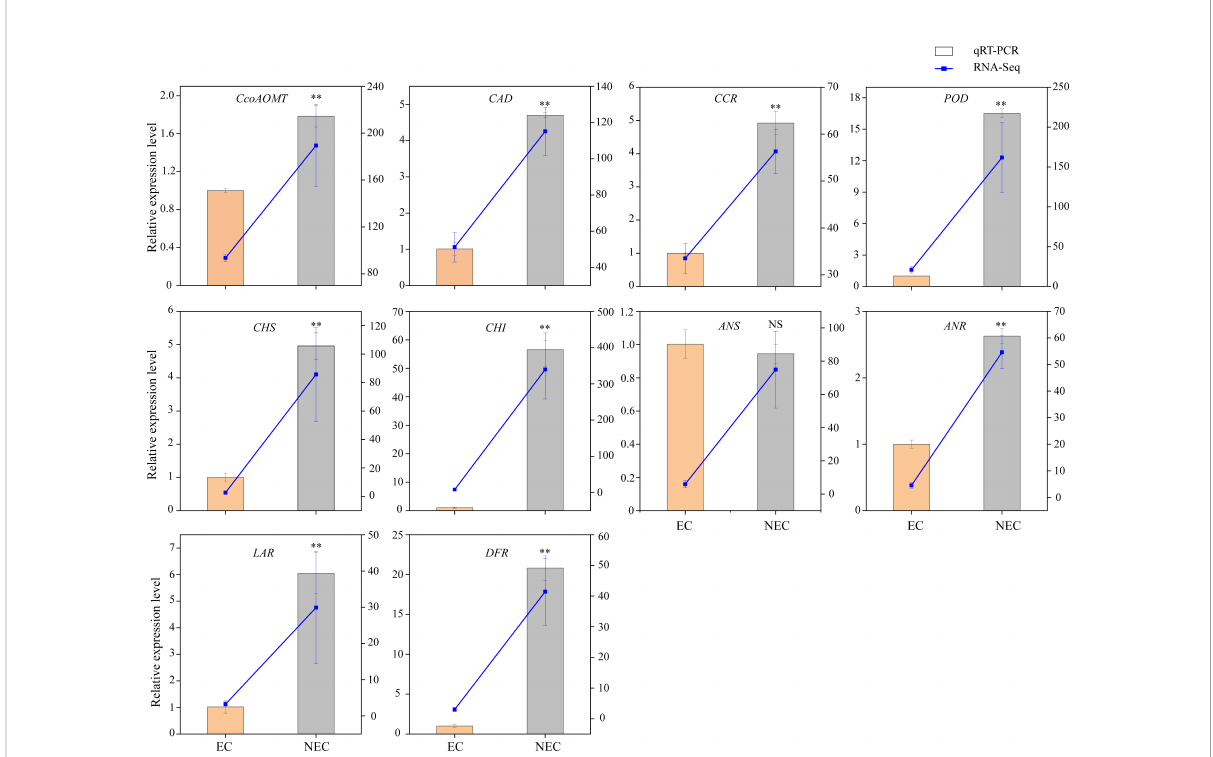
FIGURE 5 Comparison of expression pro fi les of ten selected genes in L. keampferi calluses as measured by quantitative real-time polymerase chain reaction (qRT-PCR) and RNA-seq. Columns represent gene expression determined by qRT-PCR (left y-axis), while lines represent gene expression determined by RNA-seq in FPKM values (right y-axis). The error bars represent the SD from three biological replicates. *, statistical signi fi cance at P < 0.05; **, statistical signi fi cance at P < 0.01; NS, not signi fi